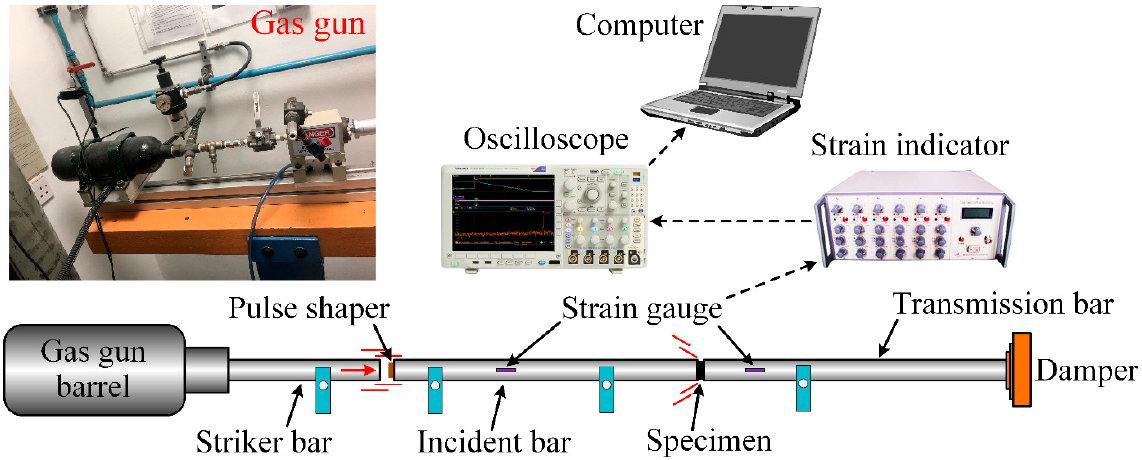
Figure 3. Schematic diagram showing the split Hopkinson pressure bar (SHPB) equipment and its data acquisition unit.